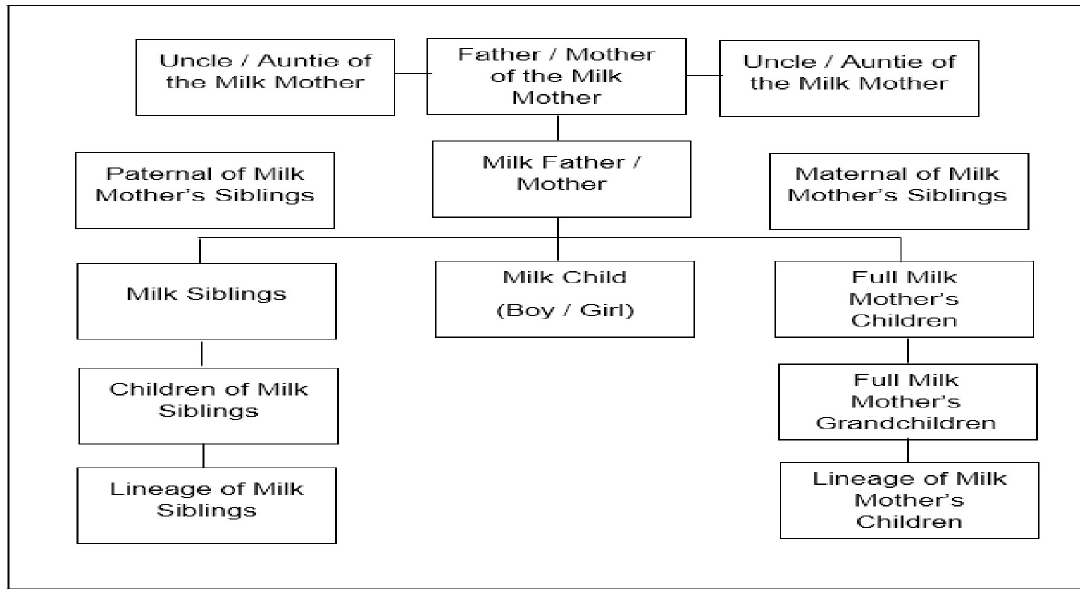
Fig 1. Relations forbidden because of milk